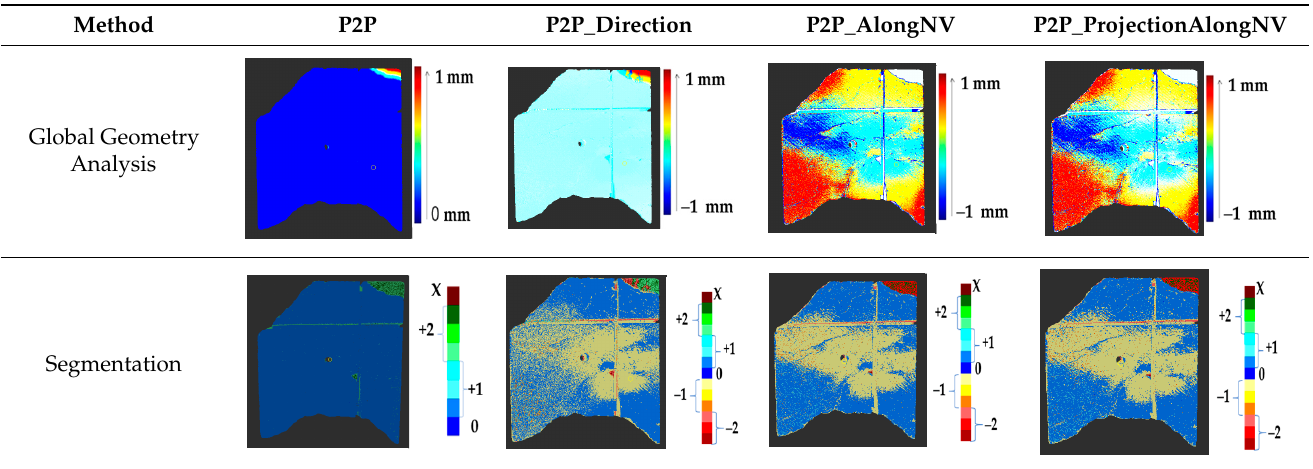
Table 18. Analysis of surface points count on the surface of NBL1.